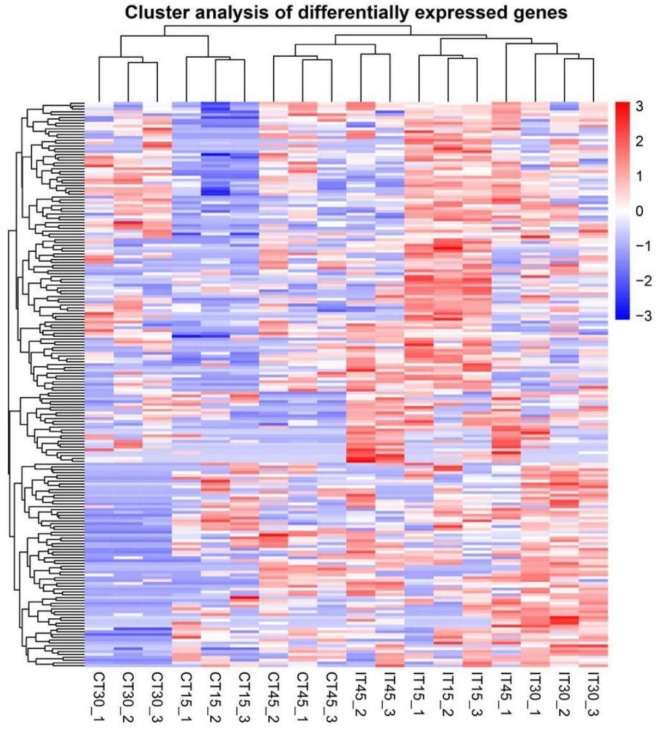
Heatmap is representing differential expression between samples.Red represents genes with high expression values, and blue represents genes with low expression values. Each treatment was replicated three times and exhibiting similar expression in each.